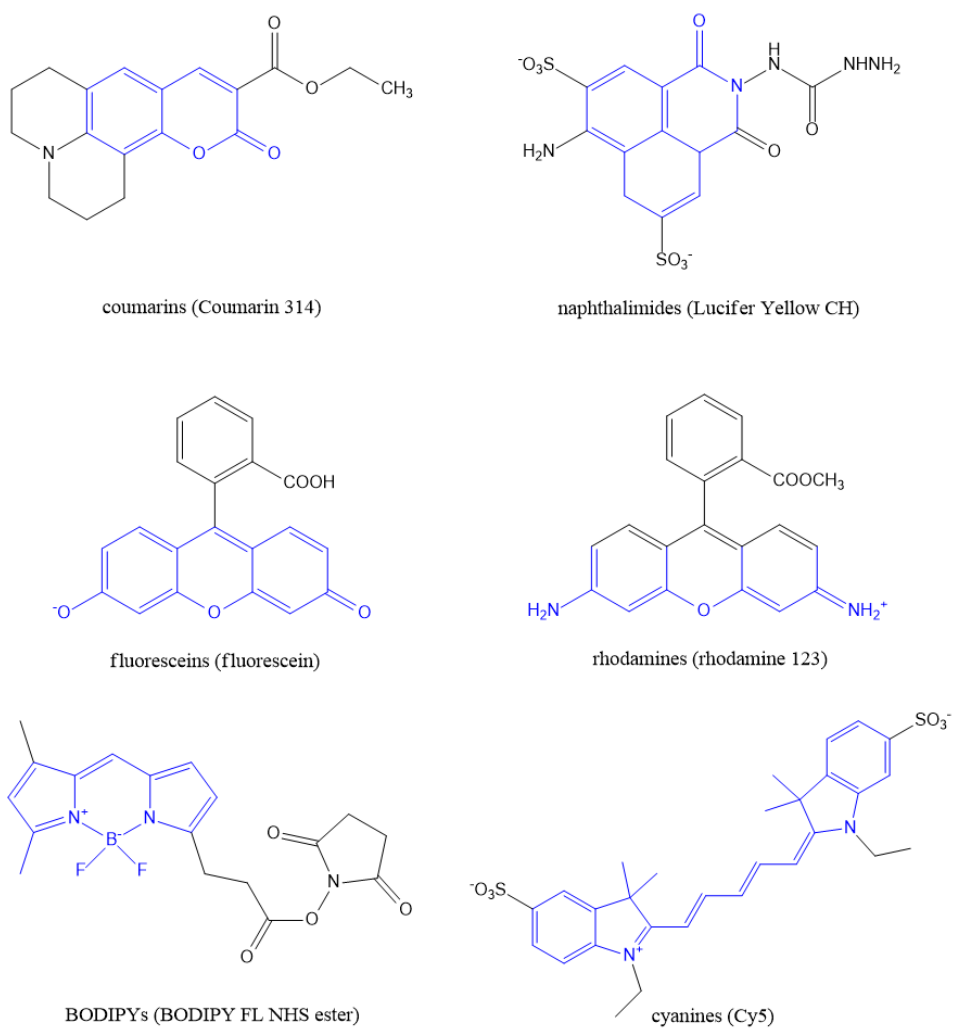
Figure 2. Representative examples of fluorophores used for labeling in biology and medicine (adopted from Ref [31]).